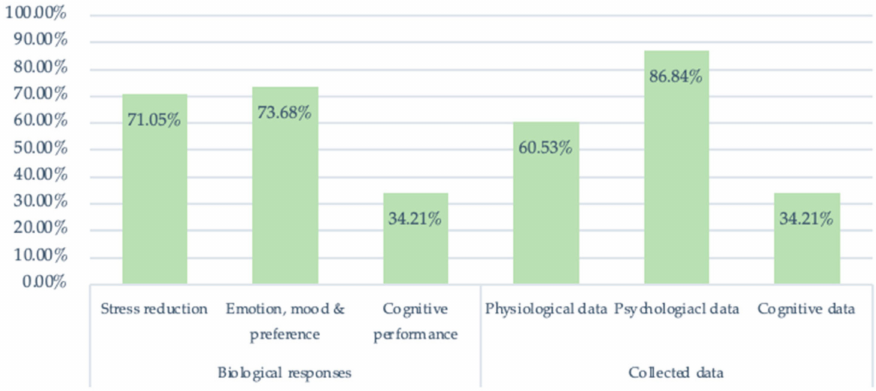
Figure 2. Distribution of the reviewed studies employing virtual natural environment based on biological responses and collected